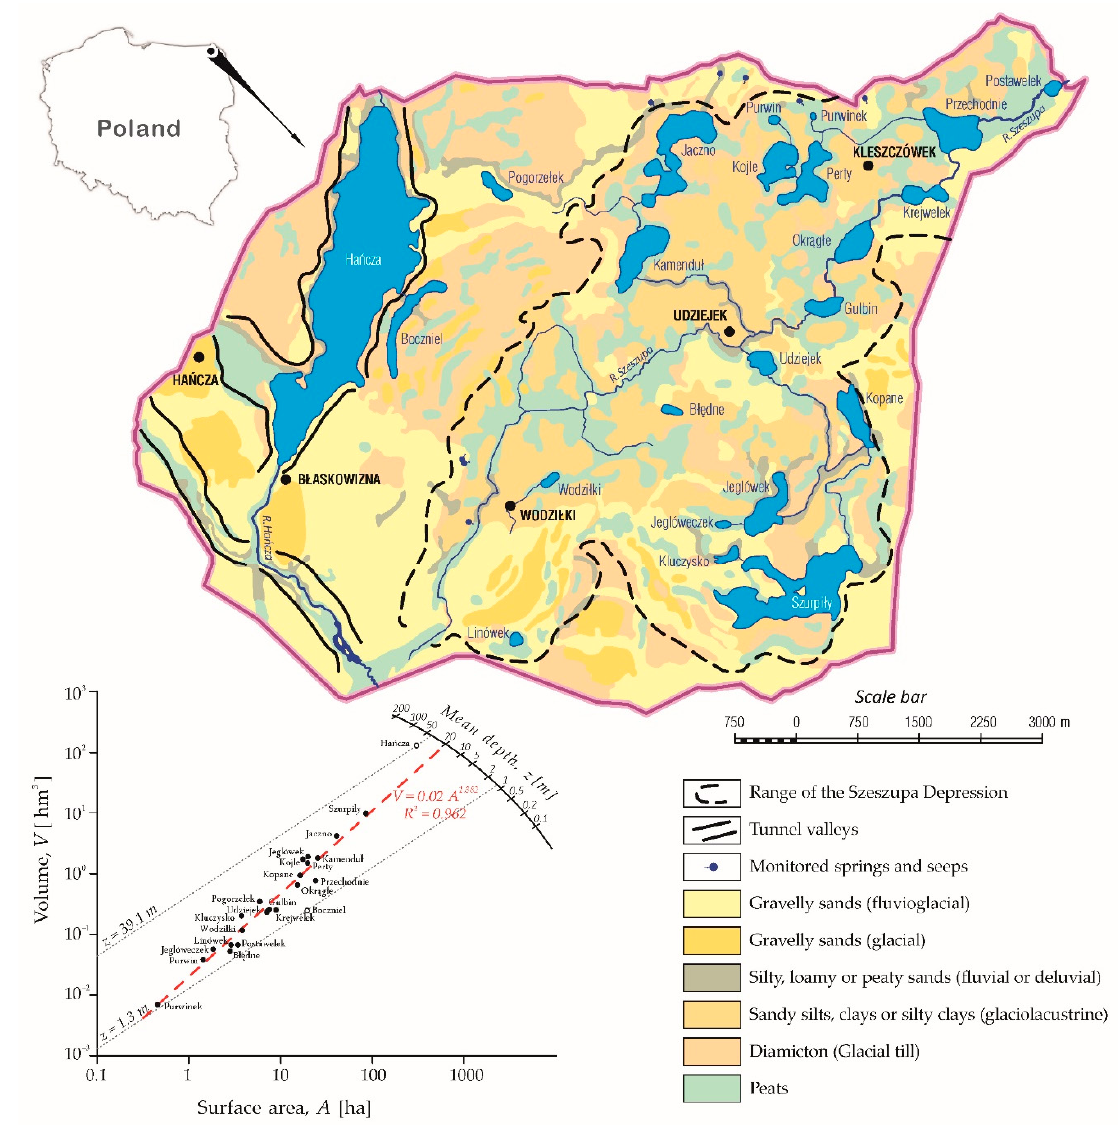
Figure 1. Location of the study area with a general lithology map of the Suwałki Landscape Park (SLP) and a graph showing the relationship between the major morphological parameters of the lake basins. The red broken line denotes the regression line between lake volume and the surface area defined for lakes of the Szeszupa Depression.